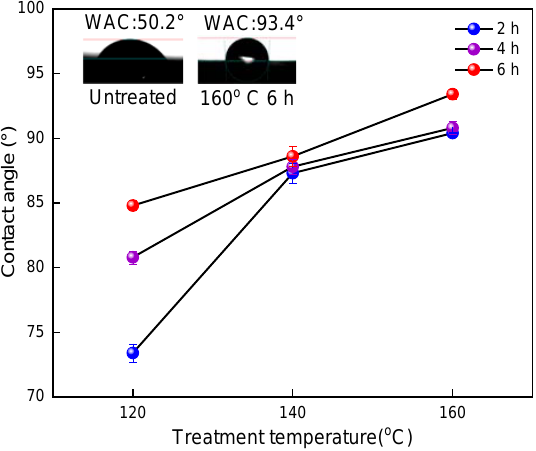
Figure 6. Contact angle of bamboo scrimber after hot oil treatment.